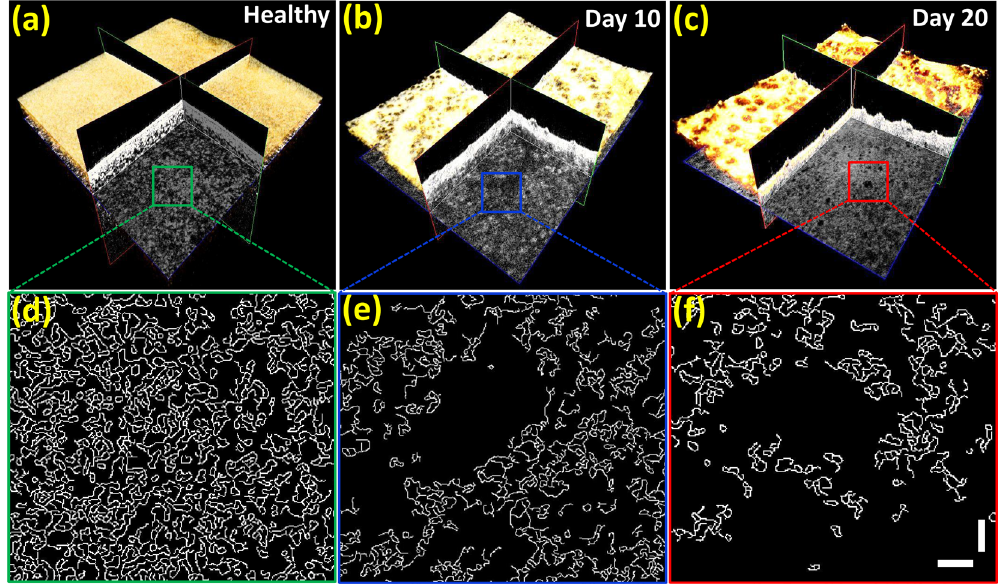
Figure 7. Tissue boundaries and behavioral changes of tissue patterns with respect to the progression of the disease using a boundary detection technique. Vertical and horizontal scale bars, 100 μ m.